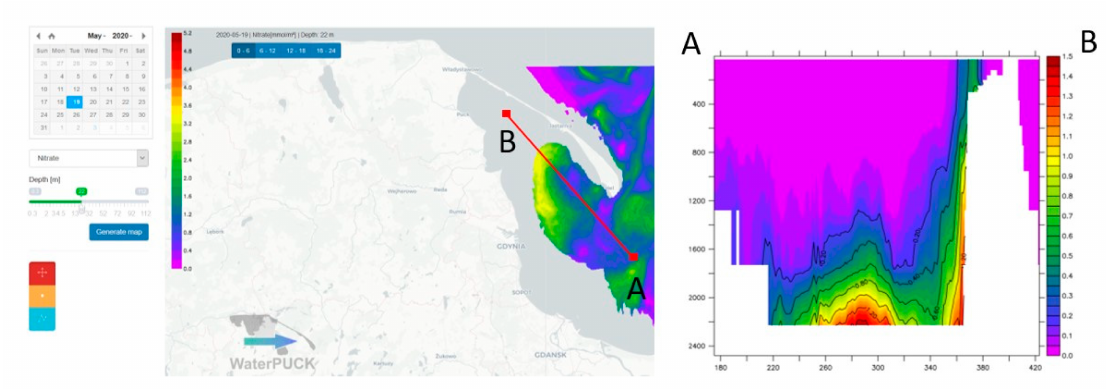
Figure 17. Screenshot of spatial distribution of nitrates concentration and sample cross section (AB - end points of the cross-section along the Hel Peninsula).